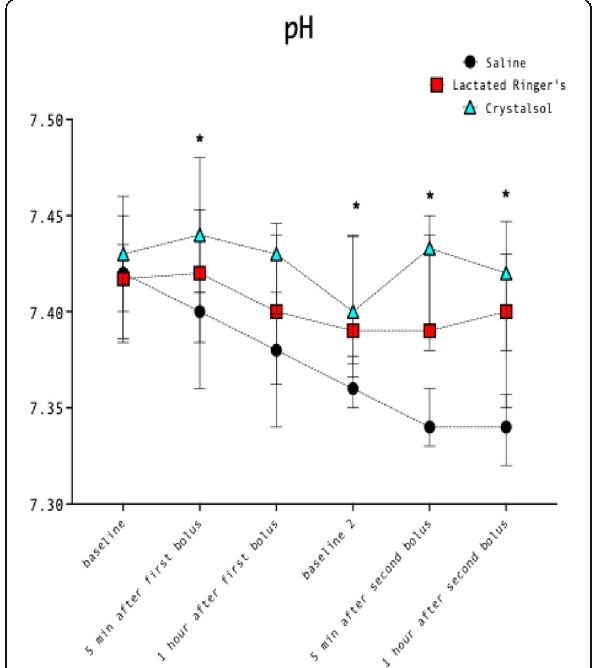
Fig. 1 (abstract A23). See text for description